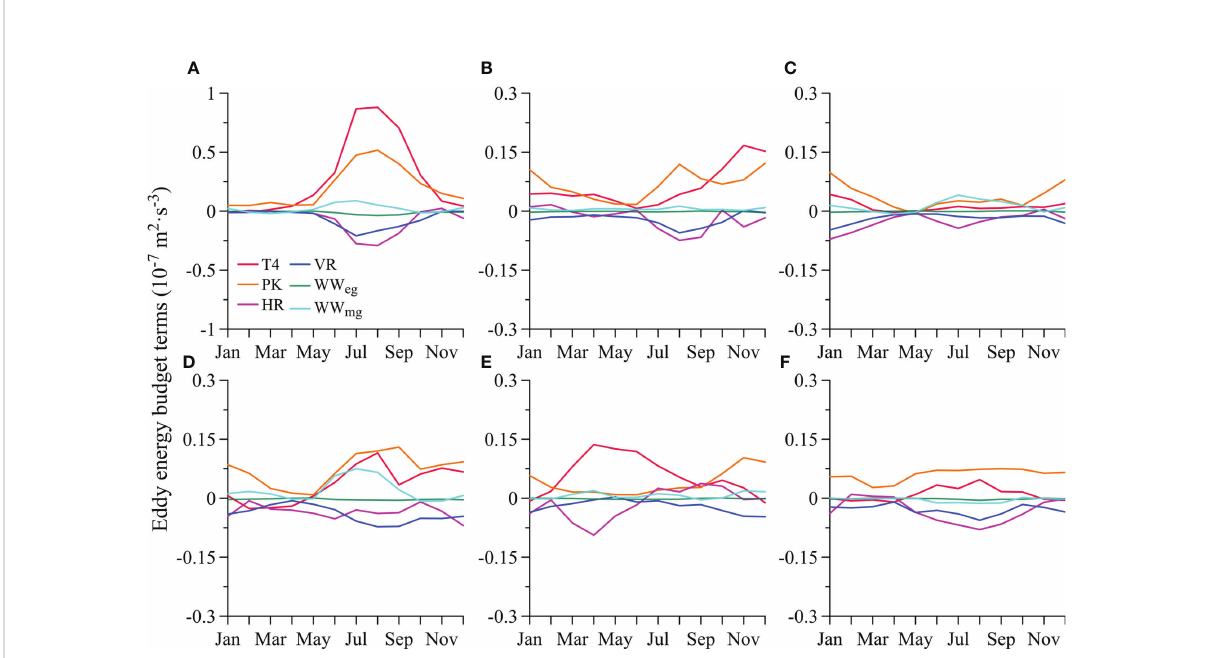
FIGURE 12 Monthly variations of barotropic conversion (T4), eddy potential energy (EPE) to eddy kinetic energy (EKE) (PK), horizontal redistribution of EKE (HR), vertical redistribution of EKE (VR), geostrophic eddy wind work (WW eg ), and mean geostrophic wind work (WW mg ) averaged in the